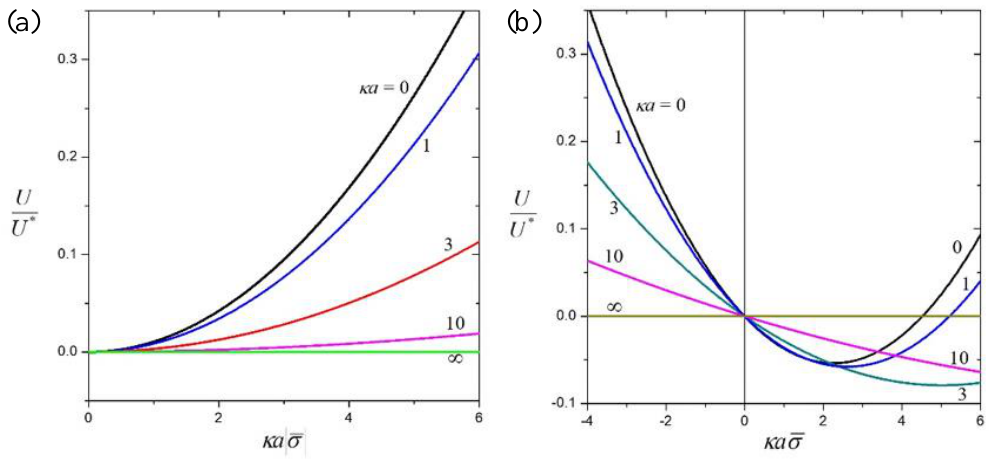
Figure 4. The reduced di ff usiophoretic mobility U / U ∗ for a suspension of hard spheres versus the dimensionless surface charge density κ a σ with ϕ = 0.1 and various values of κ a calculated for the Happel model: ( a ) β = 0; ( b ) β = − 0.2.